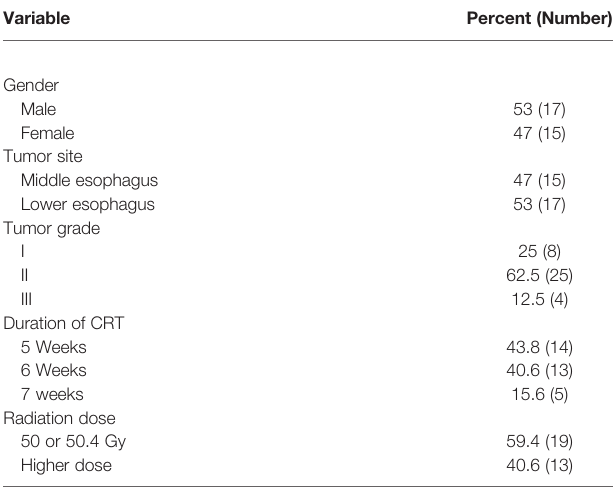
TABLE 1 | Background characteristics of the subjects at the beginning of the study. Variable